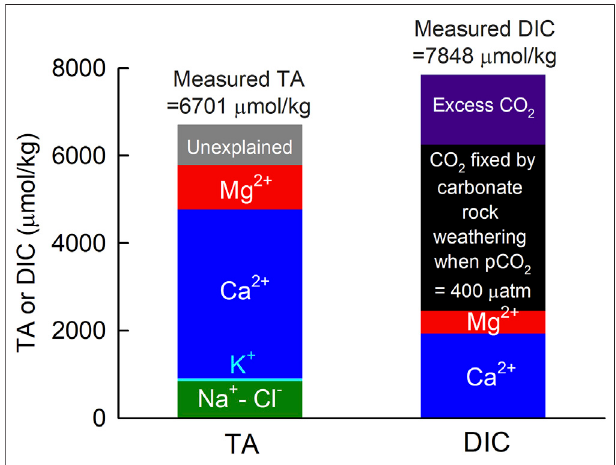
FIGURE4| EstimatedTAandDICofthespringwateratstationS5using major ion concentrations and the excess CO 2 calculated with measured TA and pCO 2 (cid:2) 400 μ atm, assuming the air – water CO 2